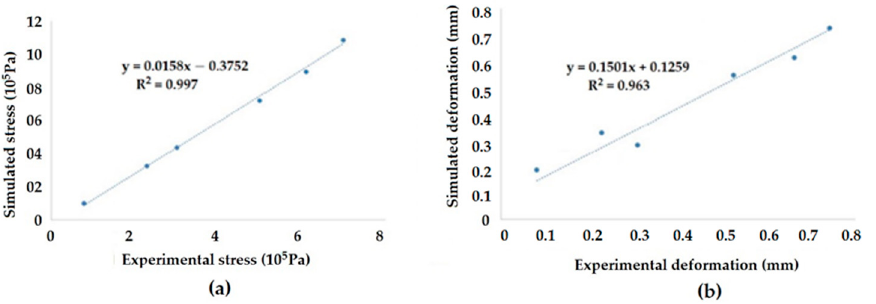
Figure 23. Correlation of results from simulation and experimental samples ( a ) stress and ( b ) de- formation.